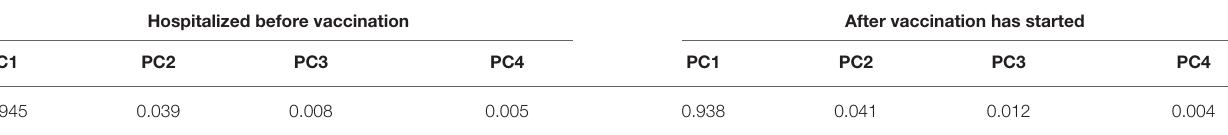
TABLE 1 | Principal component analysis (PCA) variance proportion for 4 PCs. Hospitalized before